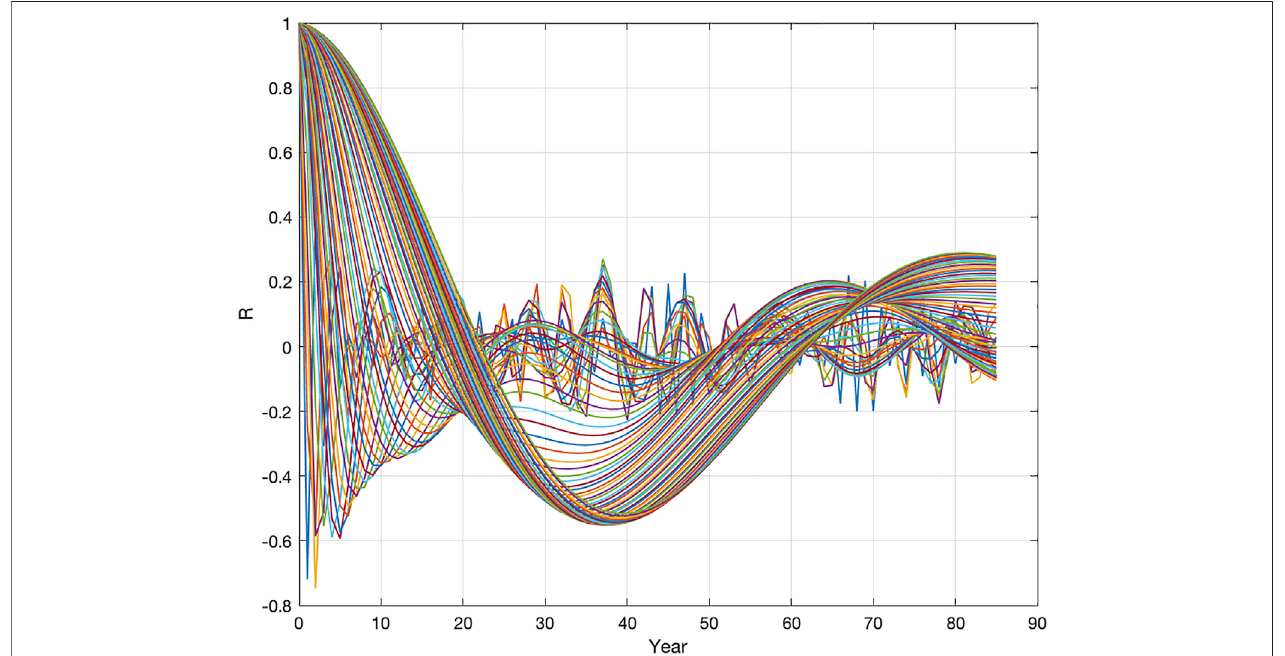
FIGURE 6 | Autocorrelations of the global land temperature wavelet spectrum, WRglt (Rglt(s), m), for s = (1 ... 85) and m = (1 ... 85) (yr.).